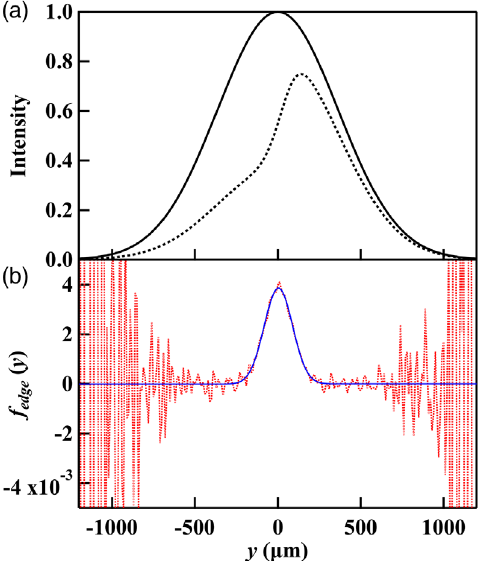
y Þ (solid curve) and FIG. 10. (a) Calculated beam profiles I beam ð I y Þ (dotted curve) using Eqs. (21) and (24), respectively, filtered ð 4 . 9 μ m, σ 0 2 . 8 μ rad, σ 36 . 1 μ rad, σ 10 μ m, with σ y ¼ y ¼ y 0 Ph ¼ D ¼ 85 μ m. (b) Extracted edge profiles f y Þ with and σ FIG. 11. (a) Required SNR to measure different source sizes IRF ¼ edge ð with 5% precision and (b) the extracted electron source sizes for (dotted curves) and without (solid curves) added noise to the different input size values σ beam profiles in (a).